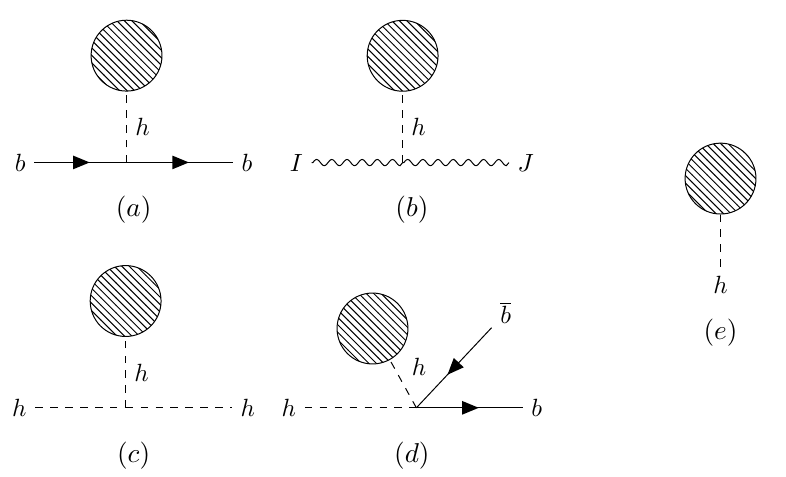
Figure 2 . NLO tadpole diagrams which appear in our calculation. In addition to contributions to two-point functions of (a) the b -quark, (b) vector bosons, where IJ = (cid:13)(cid:13); (cid:13)Z; WW; ZZ , and (c) the Higgs, the contributions to the h ! b (cid:22) b matrix element shown in (d) appear through the dimension-6 operator Q bH . In each case the diagram factorizes into the product of the tadpole function in (e) with a Higgs propagator and a Higgs coupling to the tree-level